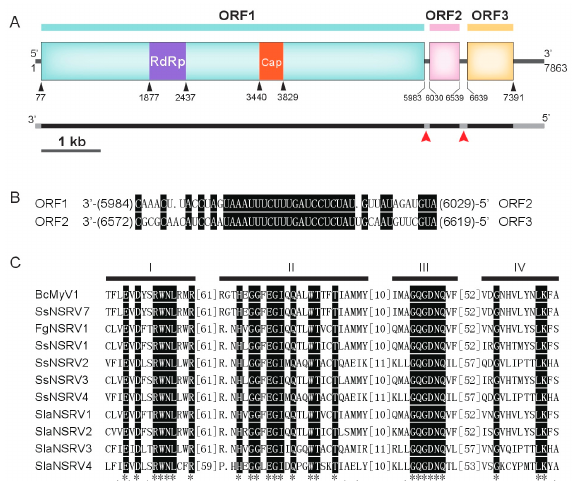
Figure 2. ( A ) Schematic diagram of the genome organization of Botrytis cinerea mymonavirus 1 (BcMyV1). The coding strand of BcMyV1 is 7863 nt long and contains three Open reading frames (ORFs), and the ORF1 encode a protein L of 1968 amino acids (aa), possessing a mononegaviral RNA- dependent RNA polymerase (RdRp) domain and a mRNA-capping region V (Cap) domain. ORF2 and ORF3 encode two proteins of 169 aa and 250 aa, respectively. The black bars indicate the coding regions, and the gray bars represent the untranslated regions (UTRs) on the genome of BcMyV1. Two red arrowheads point out the positions of a 21 nt repeat region on the two UTRs, and the detailed sequence information are listed in ( B ). The numbers in the parentheses indicate the nt positions nearby the parentheses. ( C ) Multiple alignment of the amino acid sequences of RdRp in the protein L encoded by BcMyV1 and other ( − ss)RNA viruses. “*” indicates identical amino acid residues; and “.” indicate low chemically similar amino acid residues. The abbreviations of virus names are listed in Table